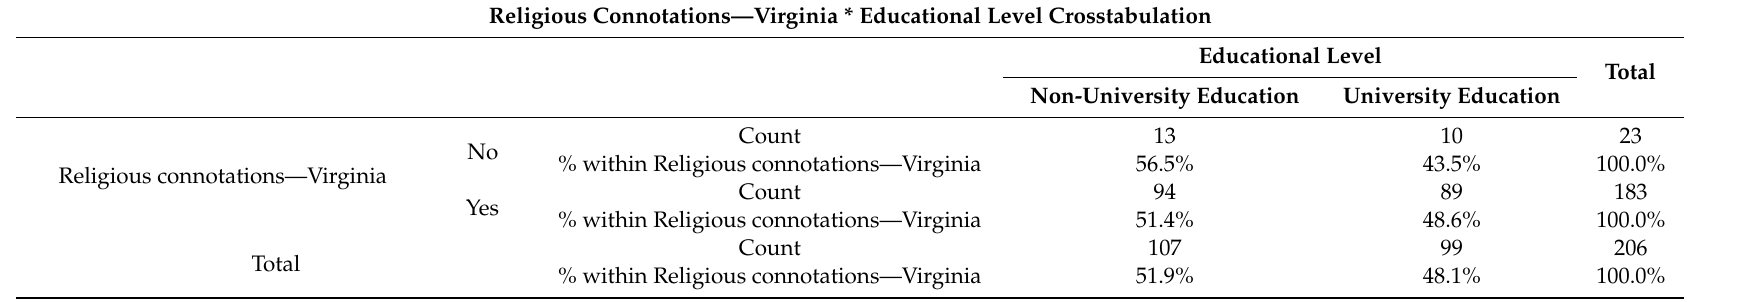
Table 8. Religious connotations in terms of educational level for the name Virginia in the metropolitan district of Leeds.